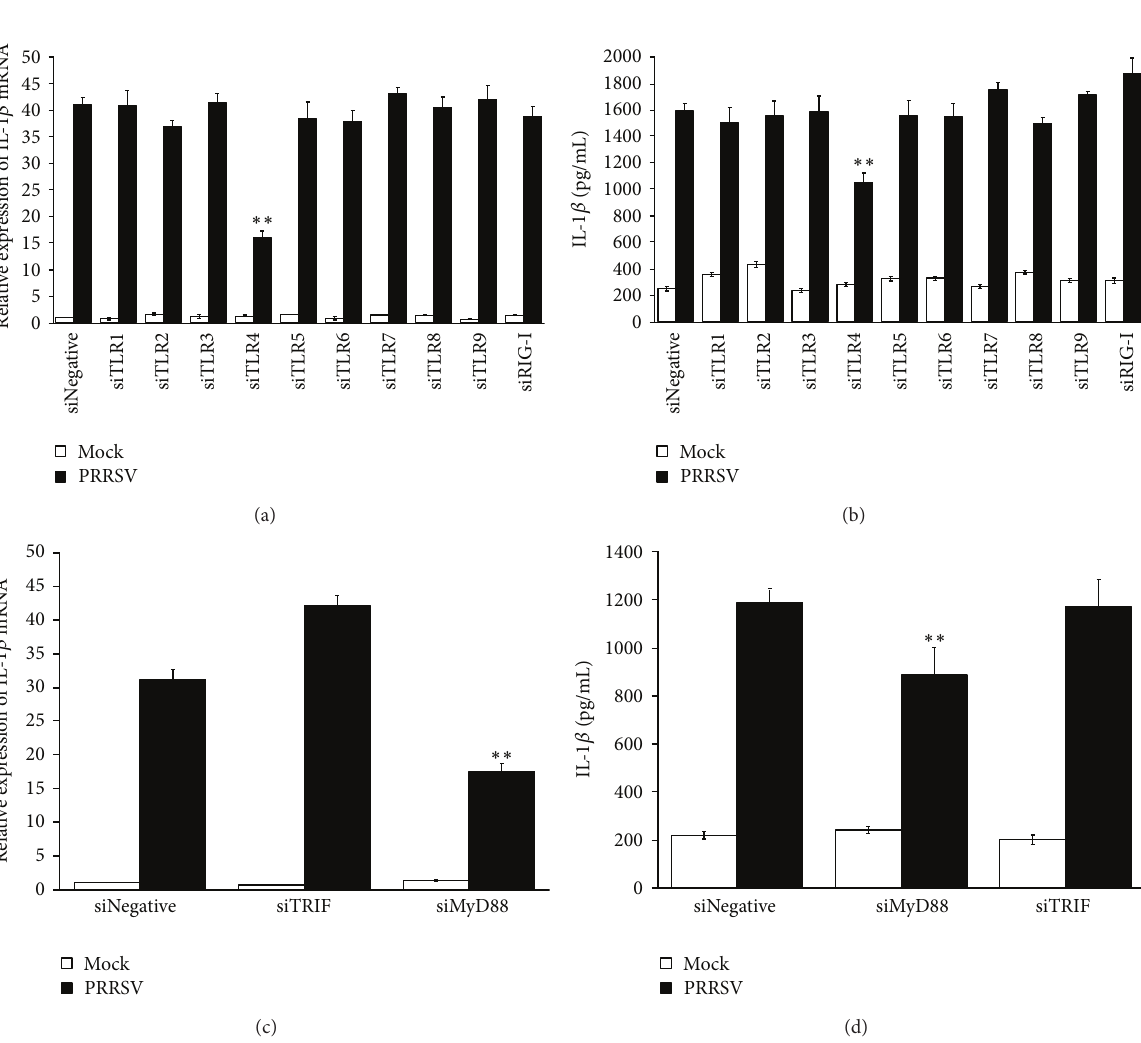
Figure 3: PRRSV-induced IL-1 𝛽 production depends on TLR4-MyD88 pathway. (a, b) PAMs were transfected with 80 nM of psiNegative, psiRIG-I, and psiTLR1-9, respectively. At 24 h after transfection, cells were mock infected or infected with PRRSV at a MOI of 0.1. The cells and supernatants were harvested separately 36 h later and subjected to porcine IL-1 𝛽 -specific real-time RT-PCR (a) and ELISA (b), respectively. (c, d) PAMs were transfected with 80 nM of psiMyD88 and psiTRIF, respectively. At 24 h after transfection, cells were mock infected or infected with PRRSV at a MOI of 0.1. The cells and supernatants were harvested separately 36 h later and analyzed by IL-1 𝛽 -specific real-time RT-PCR (c) and ELISA (d), respectively. ∗ 𝑃 < 0.05 and ∗∗ 𝑃 < 0.01 compared with cells transfected with psiNegative followed by PRRSV